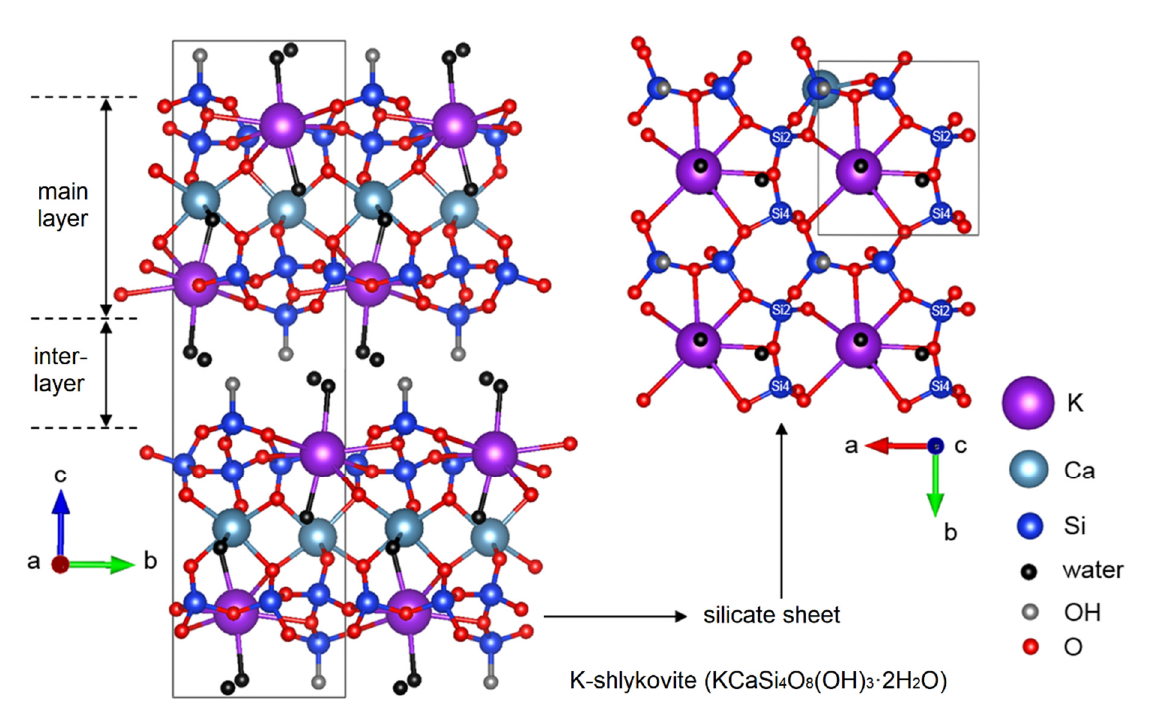
Figure 11. A schematic structure of shlykovite reproduced from [55,67], (a) viewed along [100], (b) the potassium silicate layer viewed along [001].